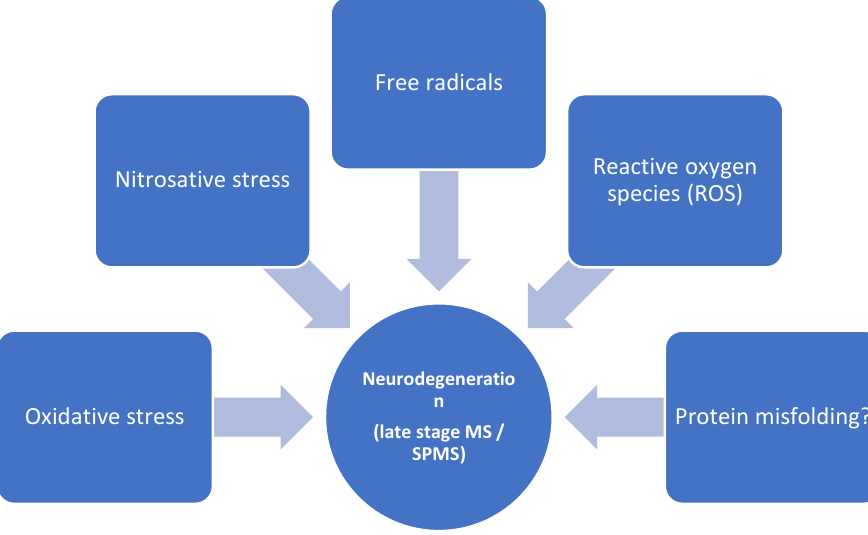
Figure 3. Potential mechanisms involved in neurodegenerative phases of multiple sclerosis.